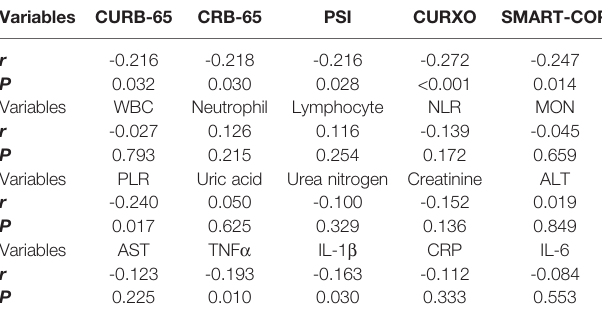
TABLE 2 | Correlations between serum IL-37 and different parameters in CAP